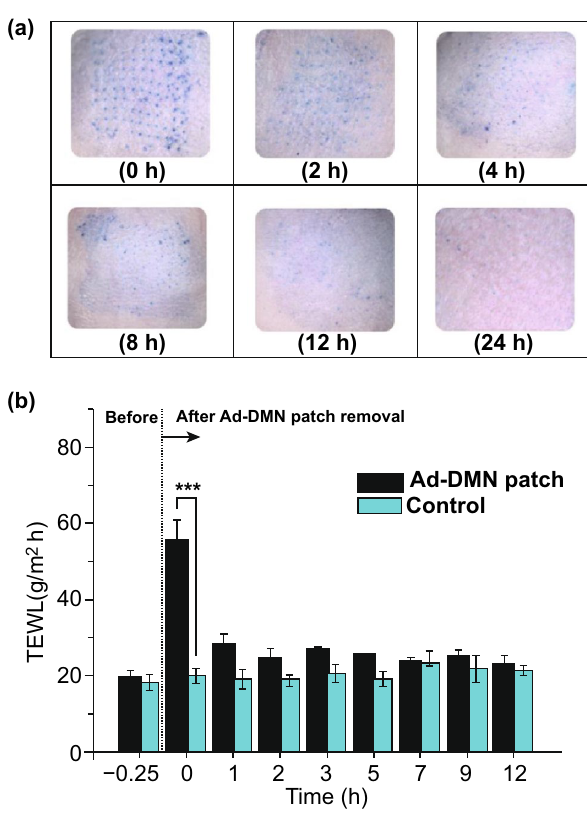
Fig. 3 a Light microscope images of mice skin over a 24-h time frame following the removal of an alpha-arbutin-loaded dissolving MN after a 2.5-h application period [71]. b Transepidermal water loss (TEWL) values to examine the skin resealing kinetics before and after the application of Ad-DMN over 12 h. Reprinted from Ref [72] with permission from